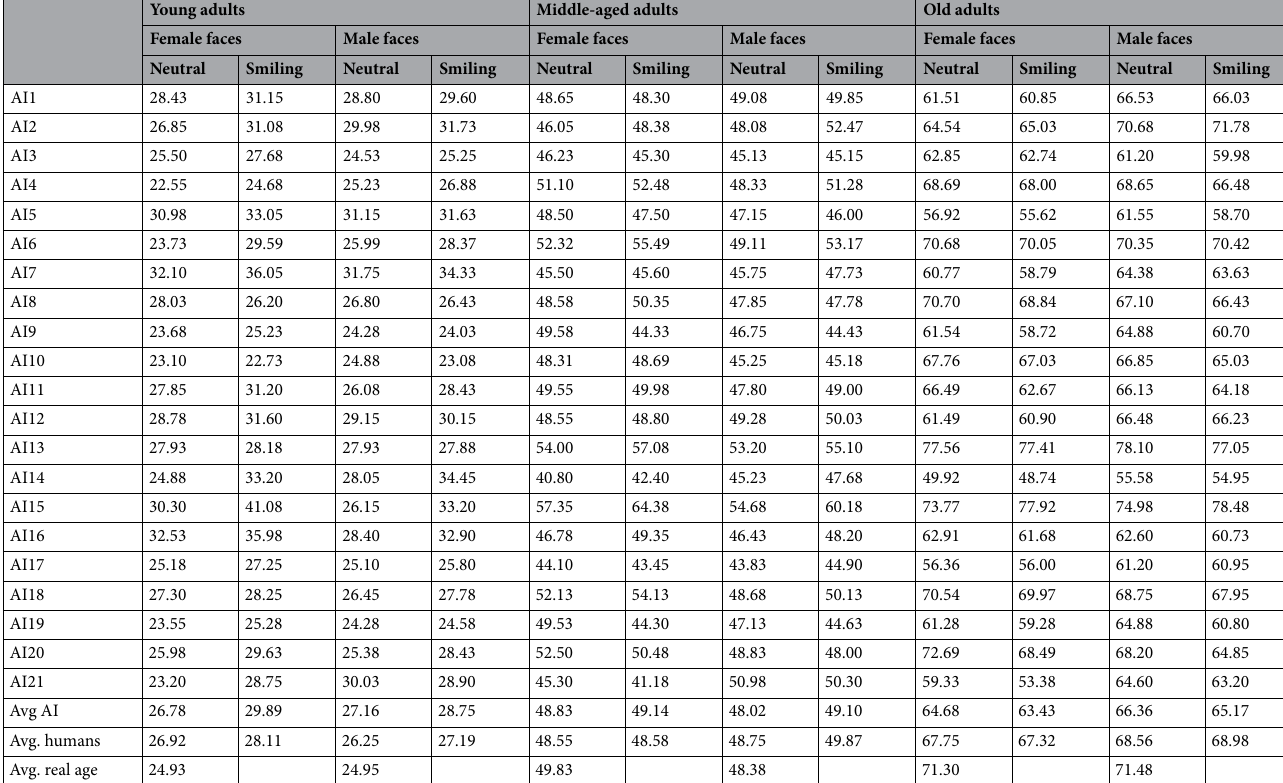
Table 3. Average estimated age (in years) for the different AIs compared to average human